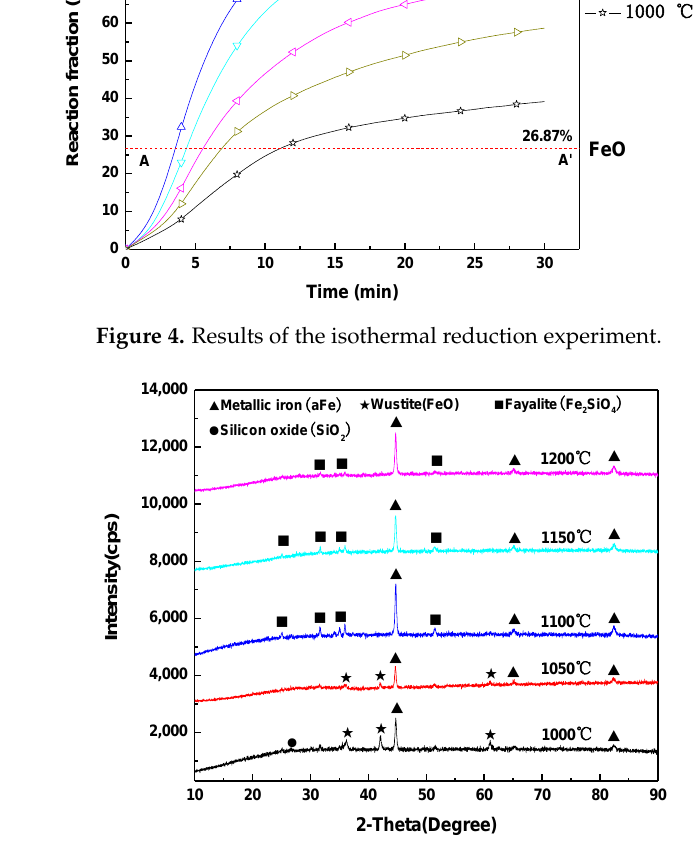
Figure 5. X-ray diffraction analysis of pellets reduced at different temperatures.